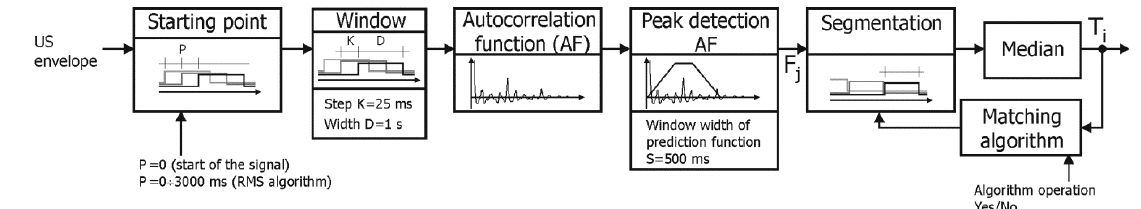
Figure 7. General block diagram of the D2 algorithm for determining the fetal heart rate based on a raw US signal.